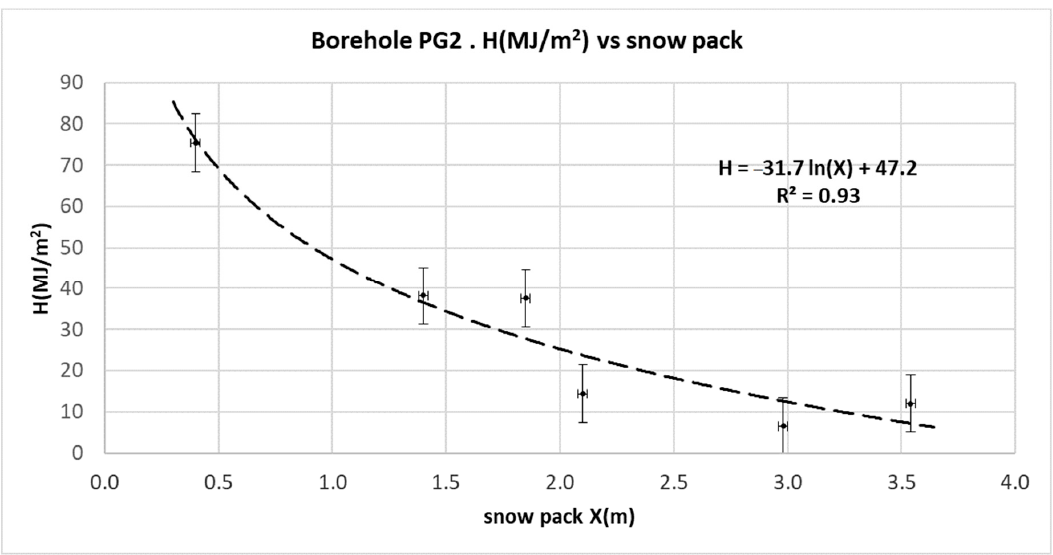
Figure 7. Correlation between the snow thickness and the soil surface energy exchange in PG2 and fit to a logarithmic function.